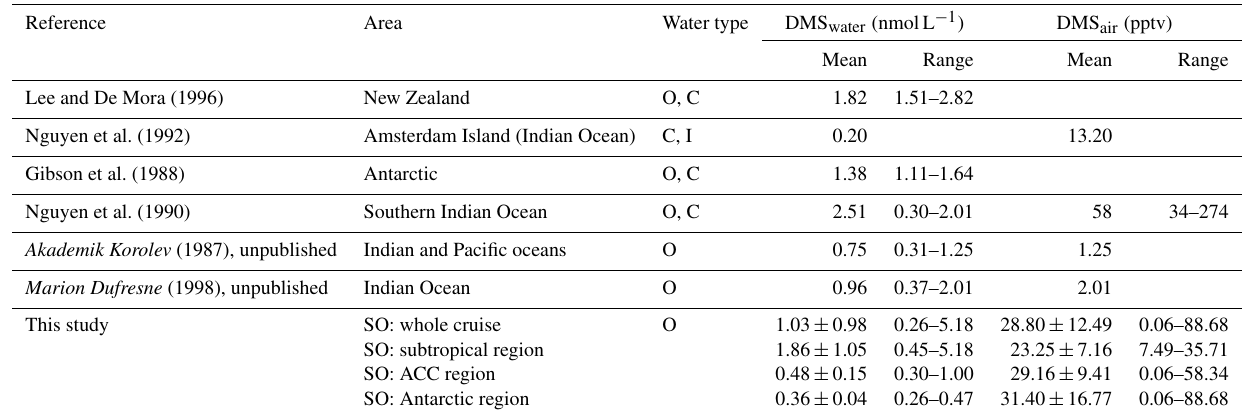
Figure 3. Auxiliary parameters. In situ measurements of (a) salinity, (b) wind speed at 18m (black) and light levels (red), (c) air temperature (black) and SST (red), and (d) cruise track latitude (black) and cruise track longitude (red) averaged over 10min. The bars across the top of the figure denote the different hydrographic regions discussed throughout the text. Table 1. Literature review of published field studies of DMS concentrations and mixing ratios (seawater, air) during wintertime (SO: Southern Ocean; O: open ocean; I: island; C: